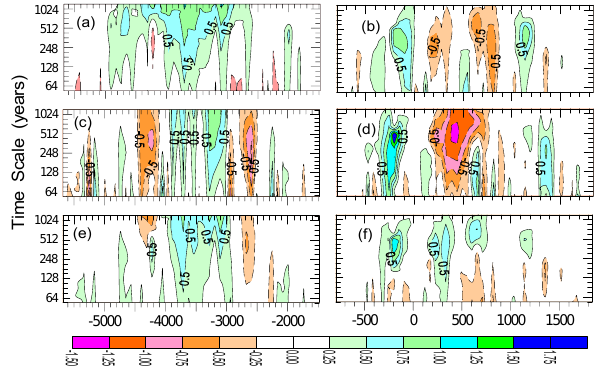
Fig. 5. Contours of the normalized scanning t -test at a 90% signifi- cance level: (a–b) for the TIC series from Pyramid Lake sediments (c–d) for the precipitation reconstruction series at same year/time- scale grids as in panels (a–b); (e–f) the coherency of abrupt changes between panels (a) and (c), (b) and (d), respectively. Contour in- terval is 0.25 but contour zero hidden. Solid lines denote positive values, dashed lines negative values.